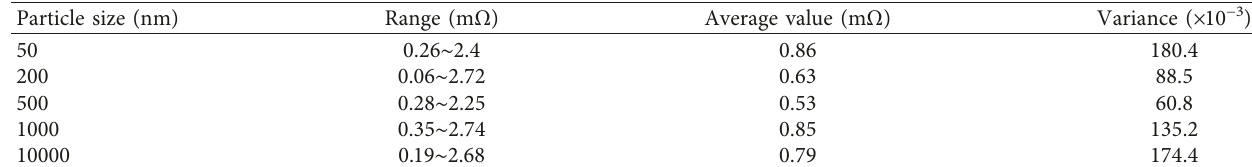
2 /Fe 2 O 3 contact material.